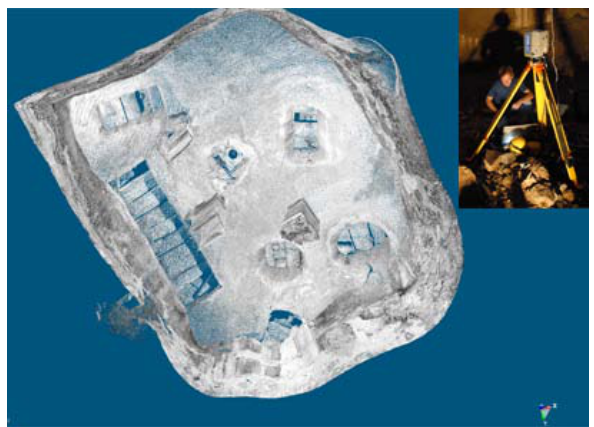
Figure 7. The point cloud of the Exterior baptistery cisterns and the scanner used